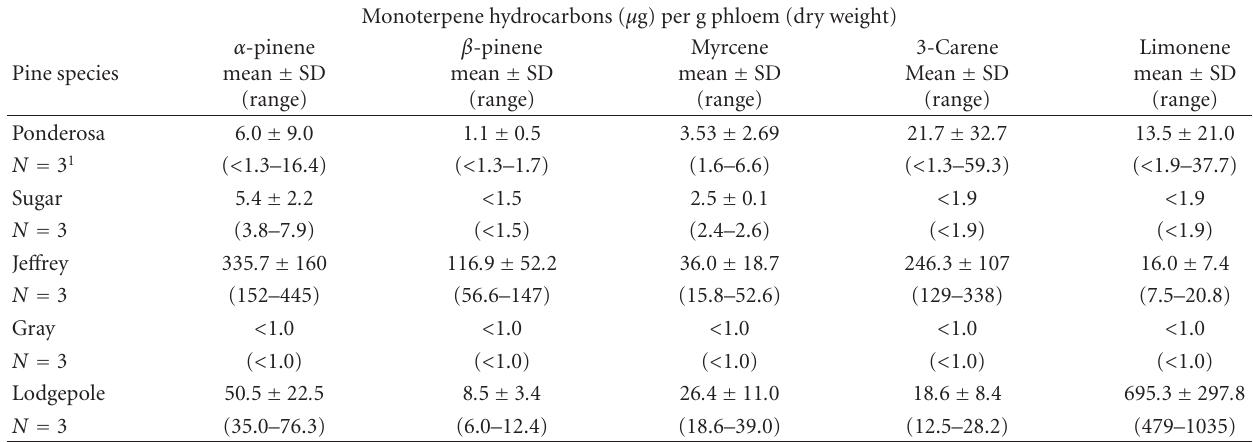
Figure 1: Gas chromatogram (Superox FA) of extract of hindguts of eight male Ips paraconfusus that had fed in Je ff rey pine. Heptyl acetate was used as an internal standard to quantify the pheromone components ipsenol and ipsdienol. Ipsenone, a related analog, eluted immediately before diacetone alcohol in a doublet peak. The mass spectrum of ipsenone is shown in the inset. Table 1: Amounts of monoterpene hydrocarbons in phloem samples (15–25 mg dry weight) from five species of pine that were fed on by Ips paraconfusus (near Bass Lake, California, USA, September 3,